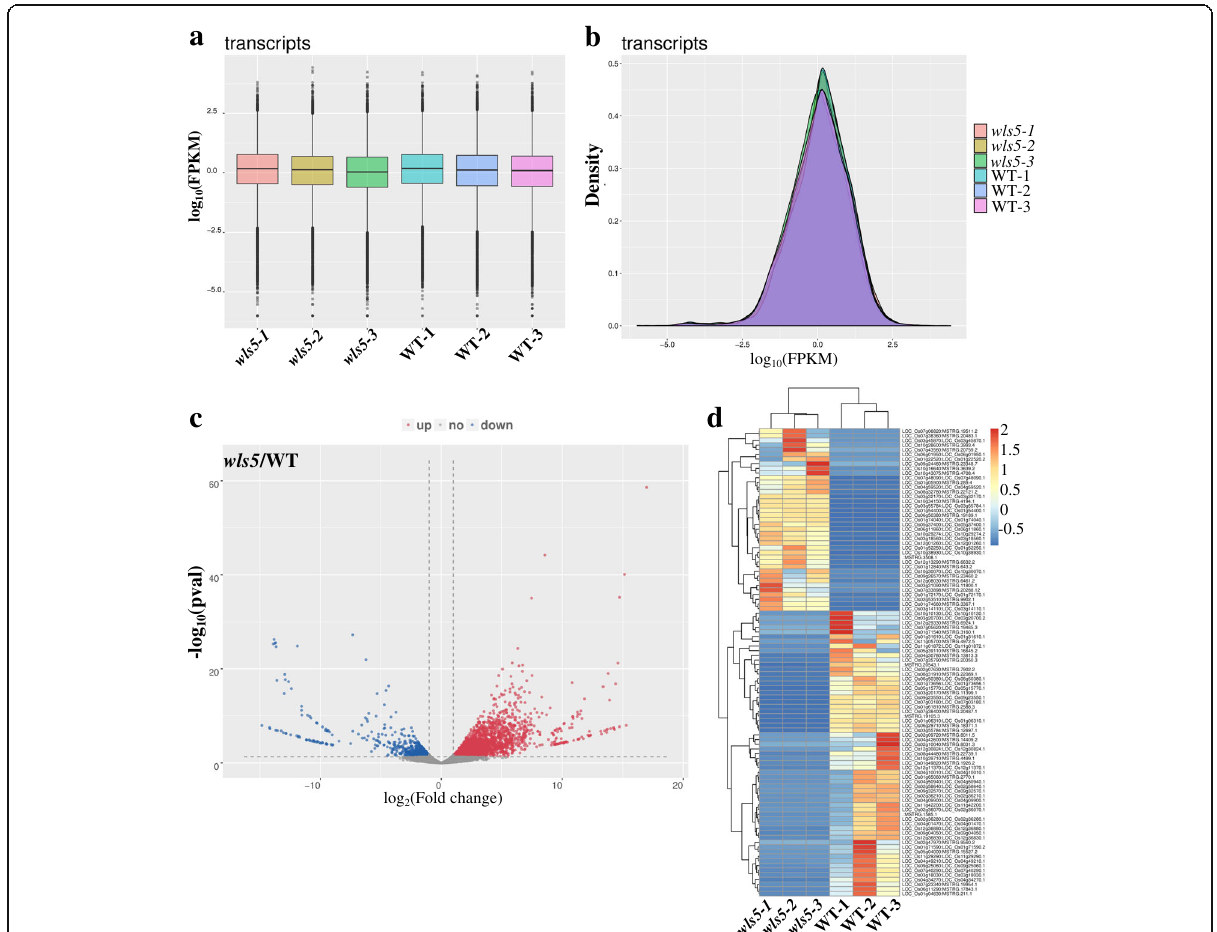
Fig. 8 RNA-seq analysis of wild-type (WT) and wls5 plants. mRNA was purified from total RNA isolated from tillering-stage plants of WT ( ‘ 93 – 11 ’ ) and wls5 . a Transcript expression boxplots of WT and wls5 plants. b Transcript expression density of WT and wls5 . c Volcano plot showing the overall alterations in gene expression between WT and wls5 . d Cluster analysis of differentially expressed genes in WT and wls5 . Red represents highly expressed genes. Blue represents poorly expressed